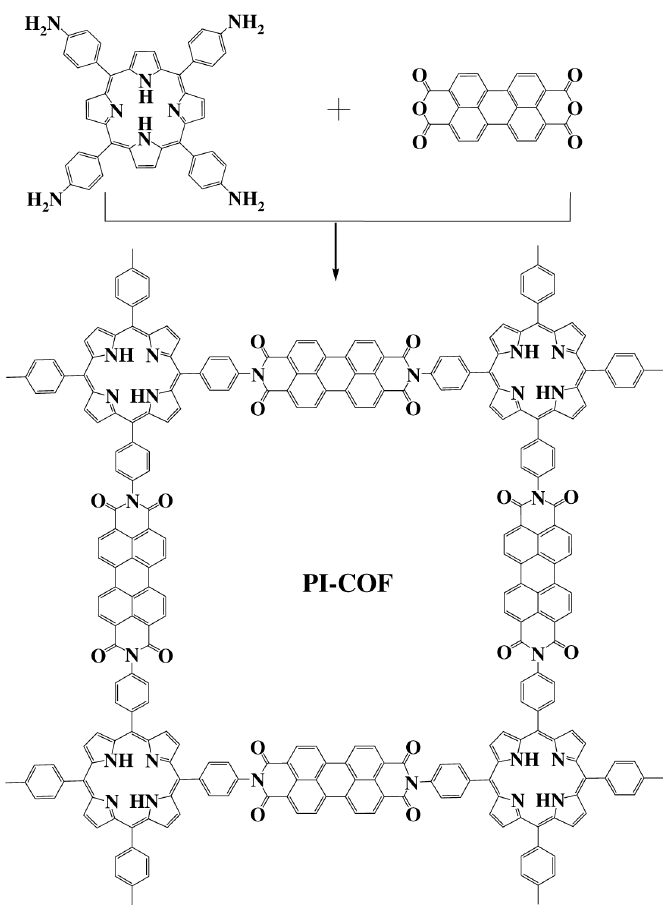
Figure 18: Synthesis and structure of